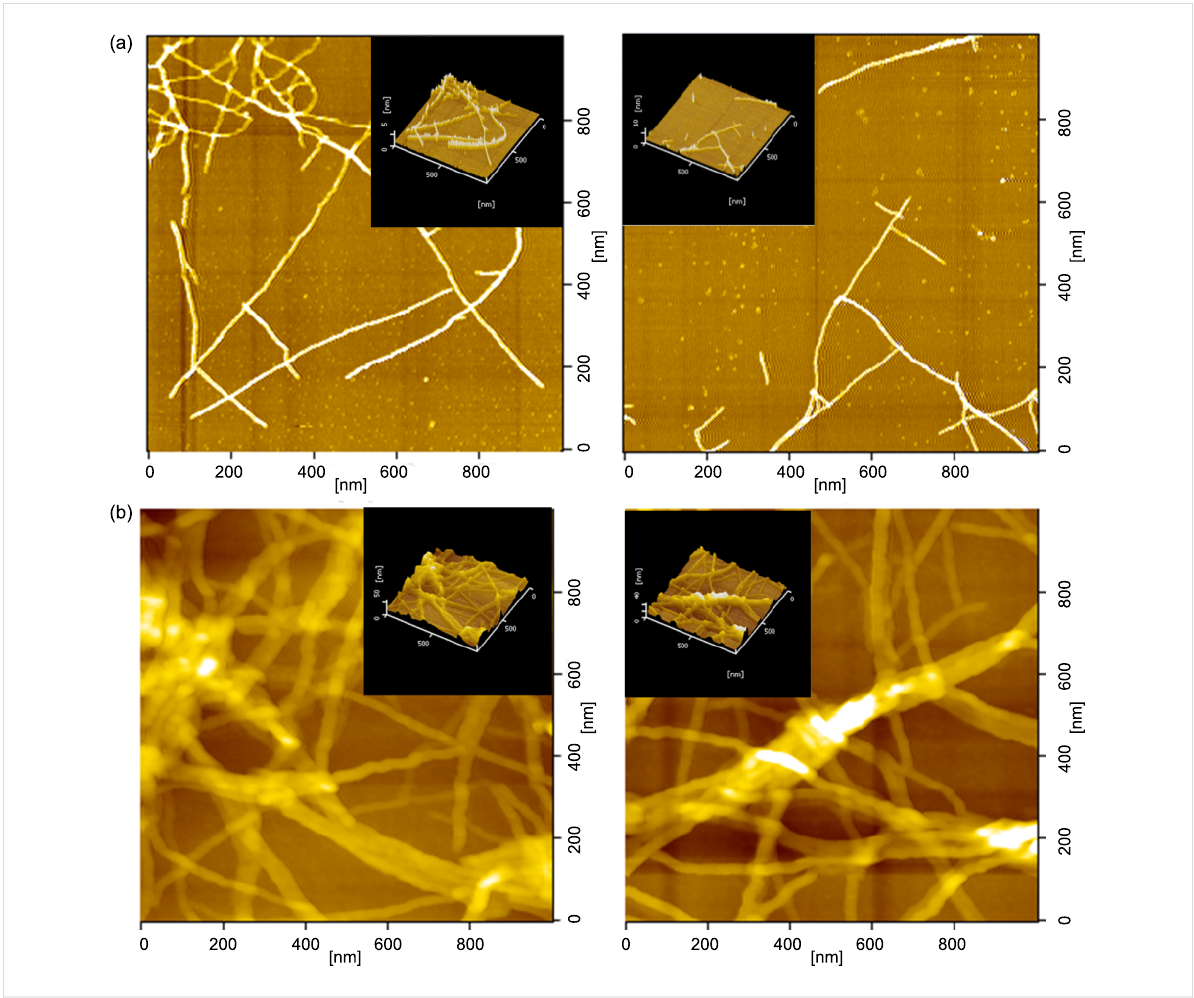
Figure 23: DFM images of (a) P3HT nanofiber and (b) P3HT/HT3P-imogolite nanofiber hybrid. Adapted with permission from W. O. Yah et al., J. Phys.: Conf. Ser. 2011, 272, 012021 [86]. © IOP Publishing 2011.